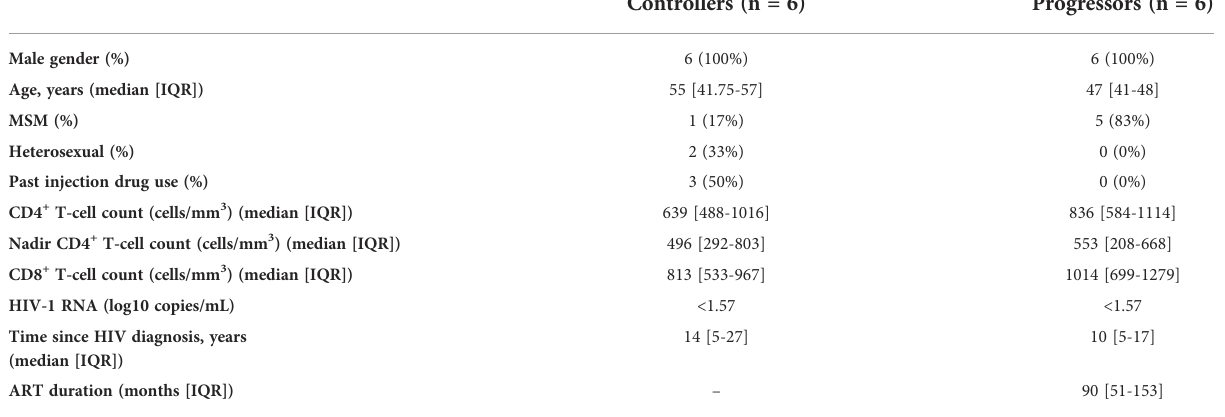
TABLE 1 General characteristics of study